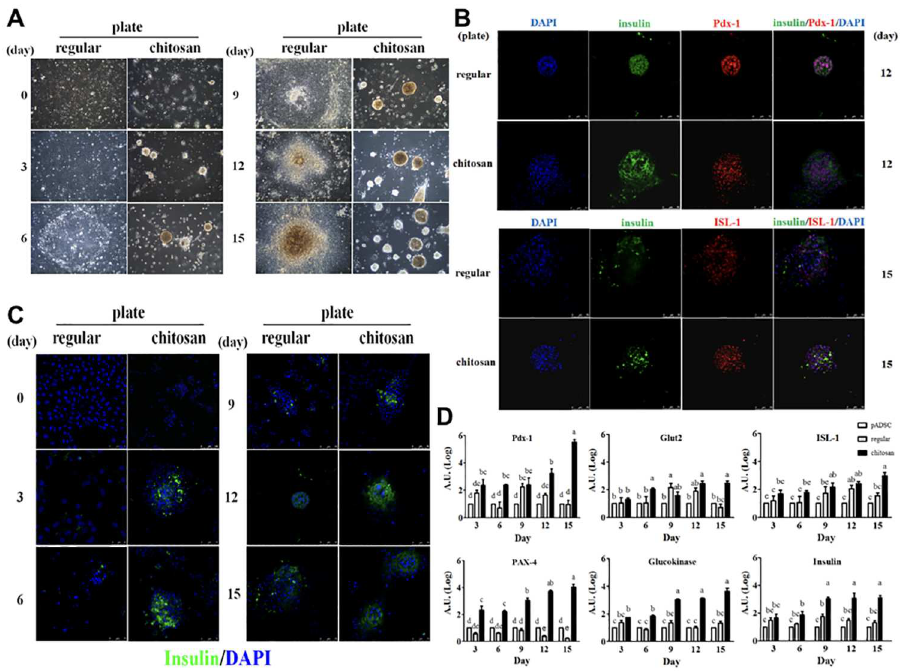
Fig 2. Chitosan enhances differentiation of pADSCs into insulin-producing Pancreatic Islet-Like Clusters (PILC). (A). Representative phase contrast microscopy analysisof the morphology of pADSC- derived PILC. Cells were differentiatedfor indicatedtimes on regular (left panels)or chitosan-coated (right panels) plates as describedin the text. (B). Representative immunofluorescence analysisof β -cell differentiation-associated markers, includingPdx-1, ISL-1 and insulin, in pADSC-derived PILC. PILC grown on regularand chitosanplates on day 12 or 15 were analyzedusing antibodiesagainstindicatedmarkers and observedunder a confocalmicroscope.(C). Effects of chitosanon the differential productionof insulinby pADSC-derived PILC. The same procedure as in (B) was performed on pADSC differentiation from day 0 to 15. (D). Quantificationof the effects of chitosanon the mRNA expressionof β -cell differentiation-associated genesin pADSC-derived PILC. Total RNA was extracted from the clusters and analyzedby real-time PCR as describedin the text. Values were normalizedto β -actin and expressedas mean ± SEM, n = 6. * , P < 0.05. (Abbreviations: Pdx-1: pancreatic and duodenalhomeobox-1; ISL-1: insulingene enhancer protein-1;PAX4: pair box gene4; GLUT2: glucose transporter